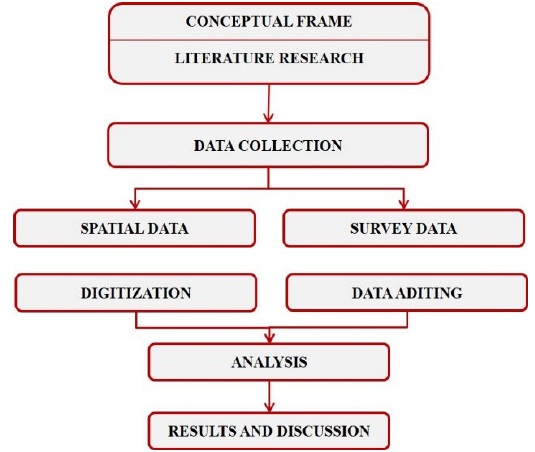
Figurel 5. Flowchart of the study.